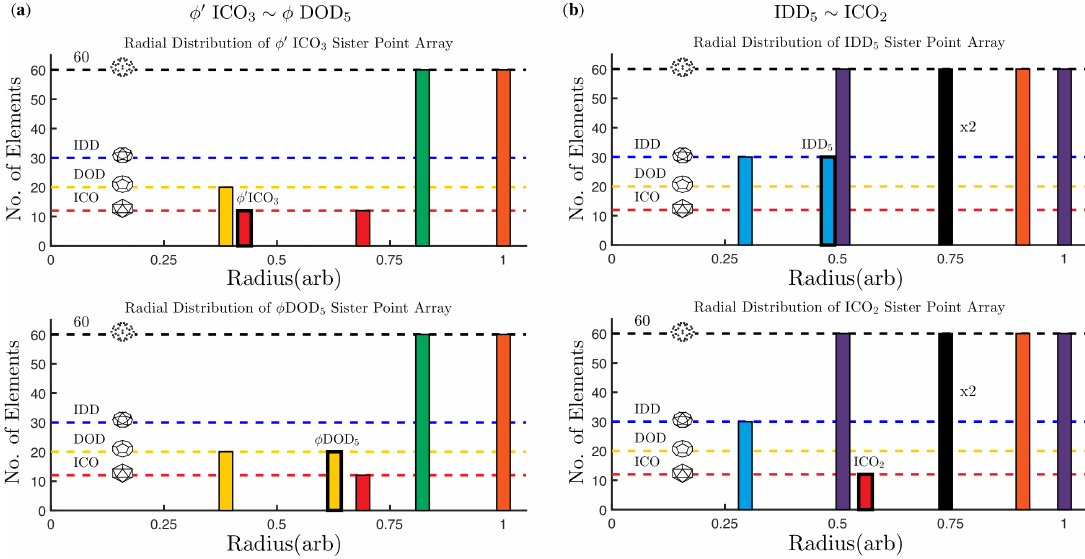
Figure 8. The radial distribution of point clouds for sister point arrays are identical, except for the base arrays (shown in bold outline). In ( a ) φ (cid:48) ICO 3 is identical to φ DOD 5 except for their two bases φ (cid:48) ICO and φ DOD. Please note that these point arrays have different affine extensions, so they cannot be combined. In ( b ) IDD 5 is identical to ICO 2 except for IDD and ICO. The bulk points at r ∼ 0.75 have two sets of 60 points one on the left and one on the right side of the 5-2 great circle in the AU. While these points have the same radius, they are not equivalent